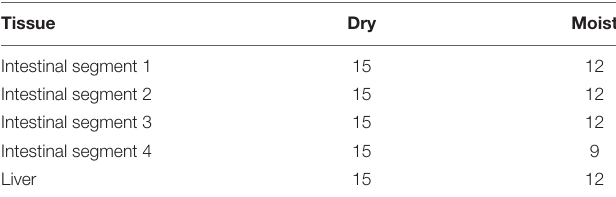
TABLE 3 | Overview of the number of intestine and liver tissue sections for each diet group that were of suitable quality for semi-quantitative histomorphological